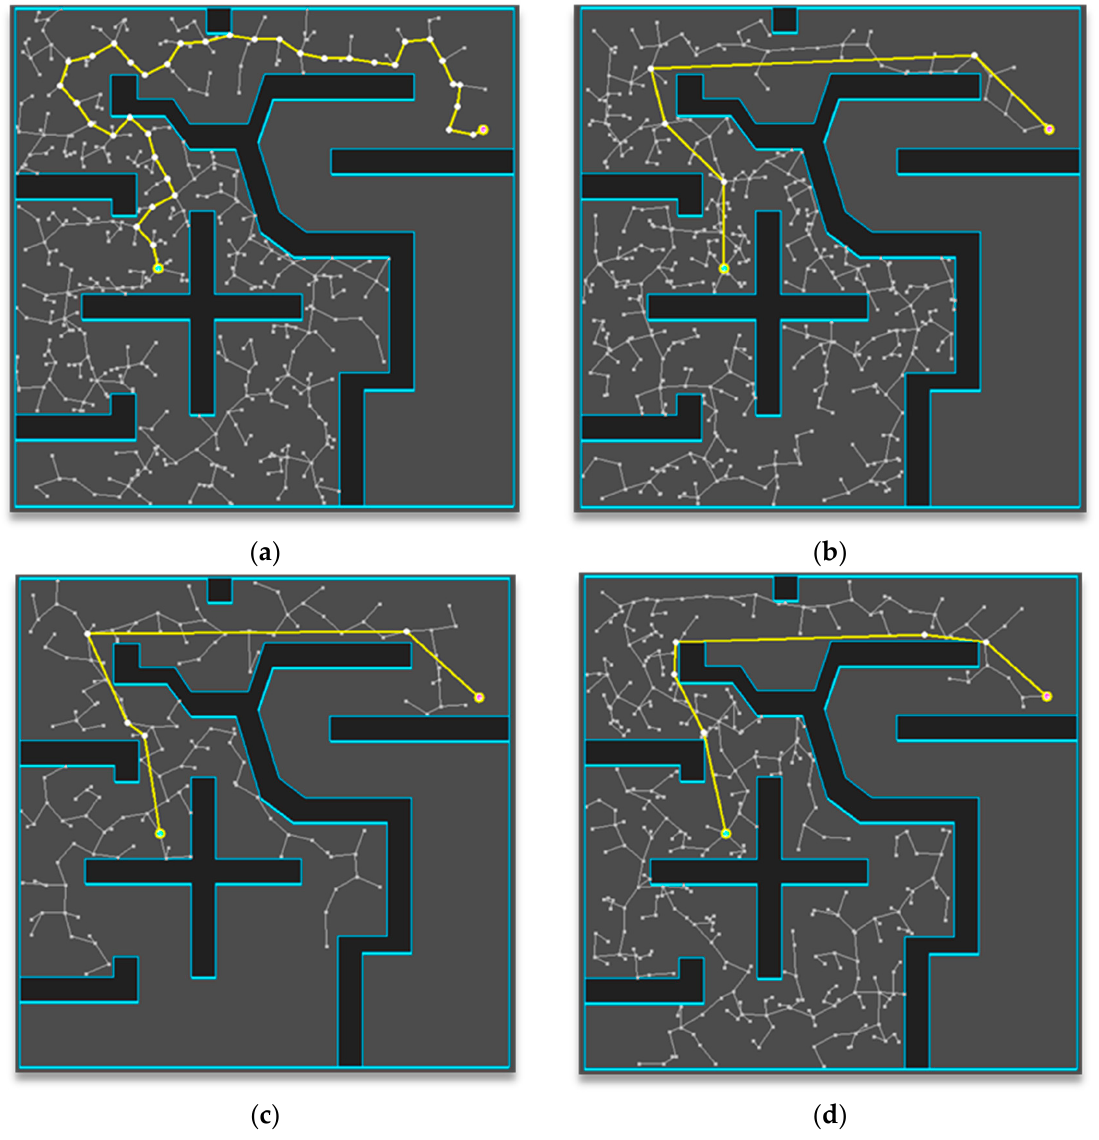
Figure 10. Experimental results of Map 2: ( a ) RRT; ( b ) Proposed method ( ε : 50 px) applied; ( c ) Proposed method ( ε : 30 px) applied; ( d ) Proposed method ( ε : 10 px) applied. Table 2. Experimental results of Map 1 (numbers in parentheses (averages of repeating trial 100 times) are relative ratios to RRT results (values less than 1 are counted as 1)).